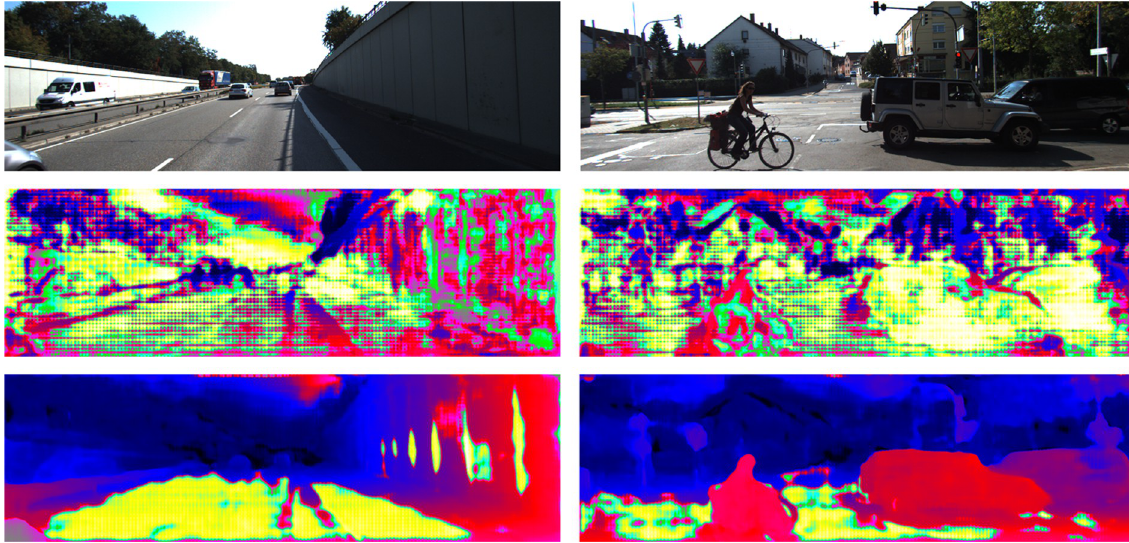
Fig 7. Attention distribution map in KITTI 2015. First line: the input left image. Middle line: attention distribution feature map extracted by 3D convolutional layers. Third line: attention distribution feature map extracted by PA blocks.